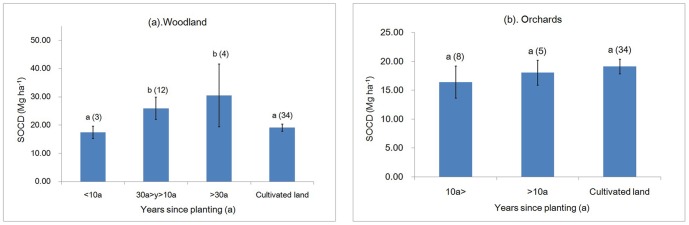
Relationship of years since planting and topsoil SOCD.* The error bars are the standard errors of the mean of SOCD and values above the bars is the number of observations (in parentheses). A different letter means a difference significant at P<0.05.